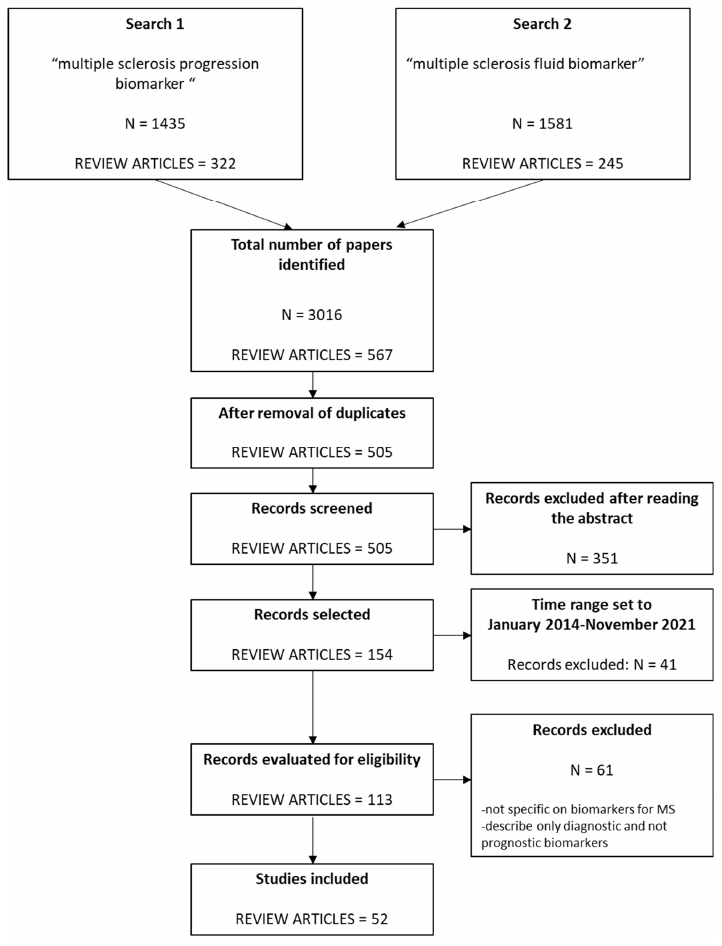
Figure 1. Flowchart of the article selection.